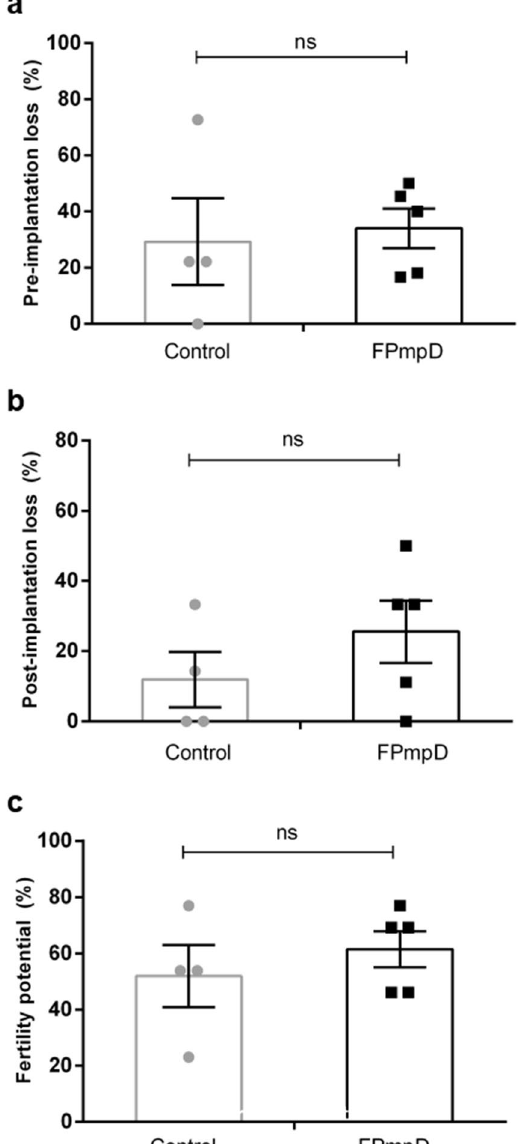
Figure 5. Fertility assay. In FPmpD-vaccinated (FPmpD) and non-vaccinated (Control) mice we evaluated: ( a ) Pre-implantation loss [(number of corpora lutea − number of implantations)/number of corpora lutea] × 100. ( b ) Post-implantation loss [(number of implantations − number of live fetuses)/number of implantations] × 100. ( c ) Fertility potential [implantation sites/corpora lutea] × 100. Each dot represents individual mouse values. Bars represent means ± SEM value for each experimental group (two-way ANOVA; Sidak post-test; ns non-significant